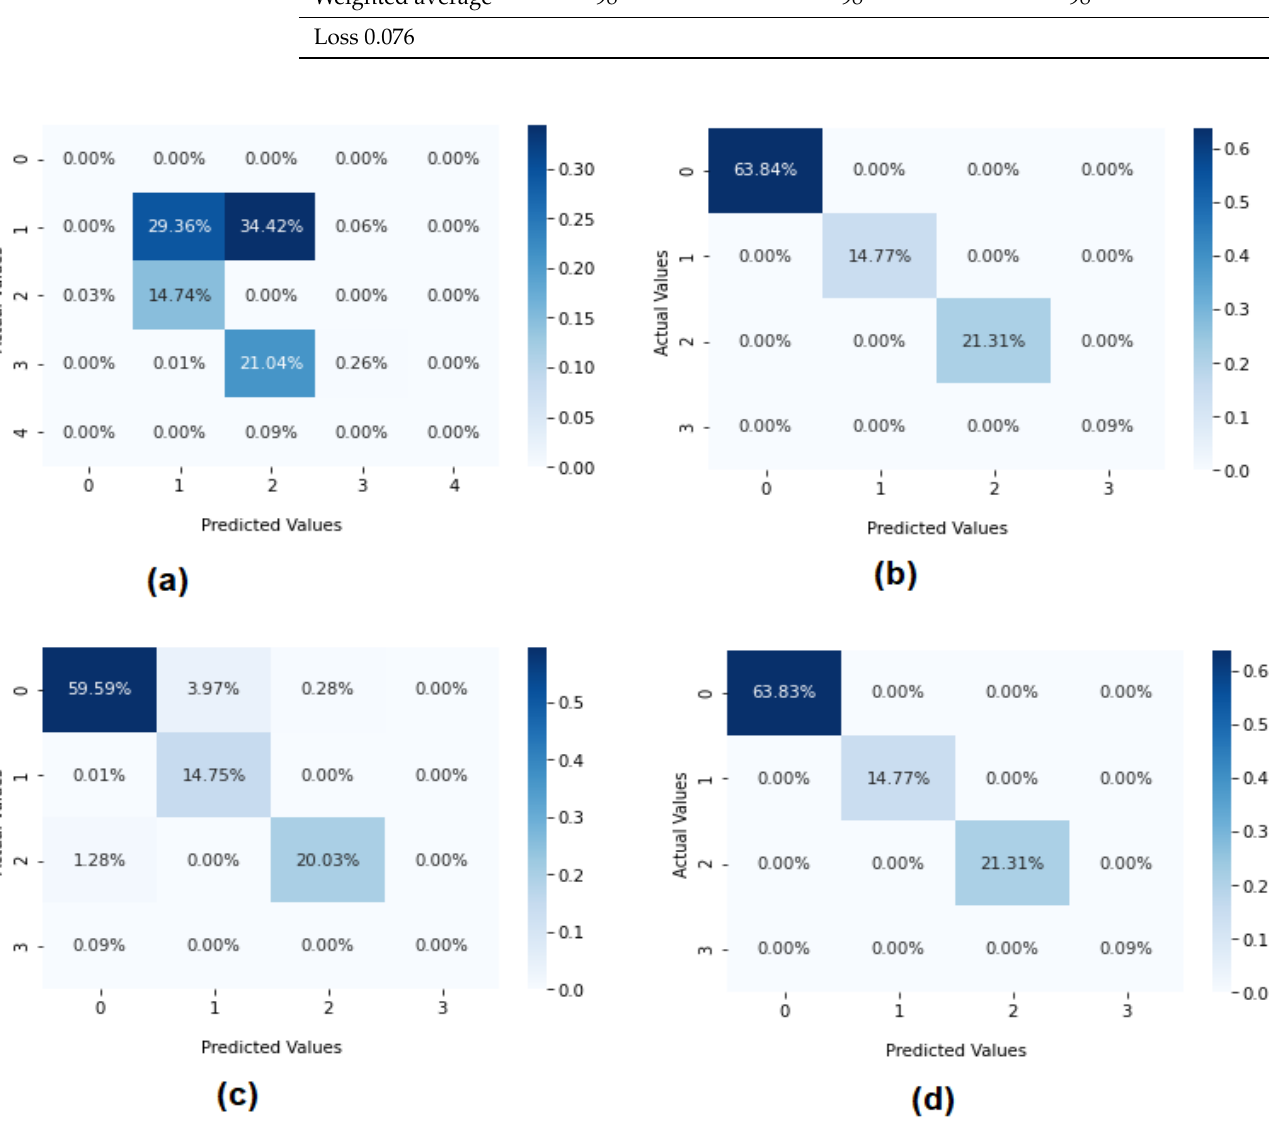
Table 12. Results of the CNN-LSTM model using the multiclass classification dataset.